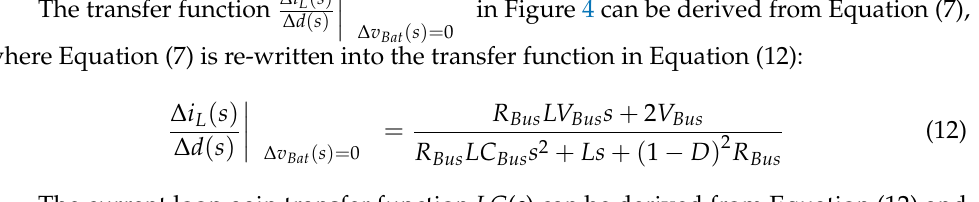
K ,  under different K Pi . Ii